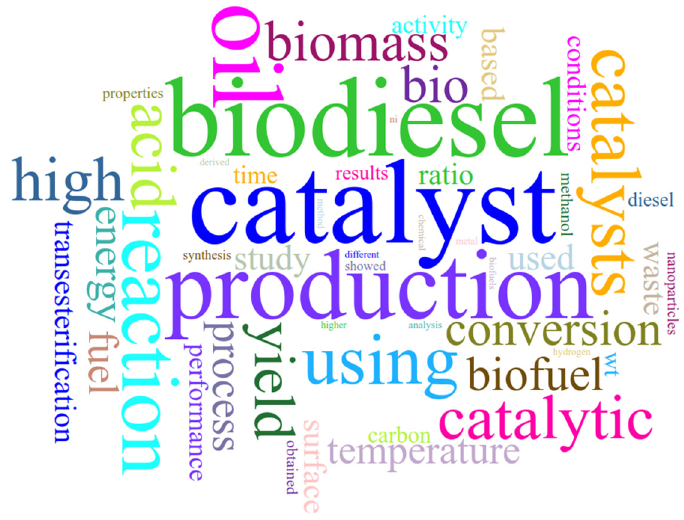
Figure 5. The word cloud from titles and abstracts.